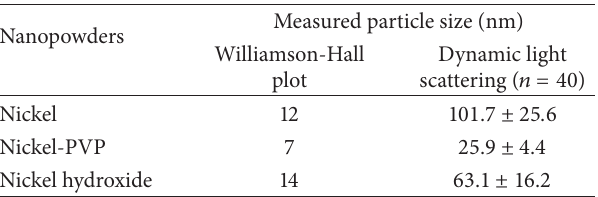
Figure 4: Williamson-Hall plot for XRD data of Ni(OH) 2 synthe- sized powder. Table 1: Particle size of the nanopowders measured using the Williamson-Hall analysis from the X-ray diffraction data and the dynamic light scattering method.